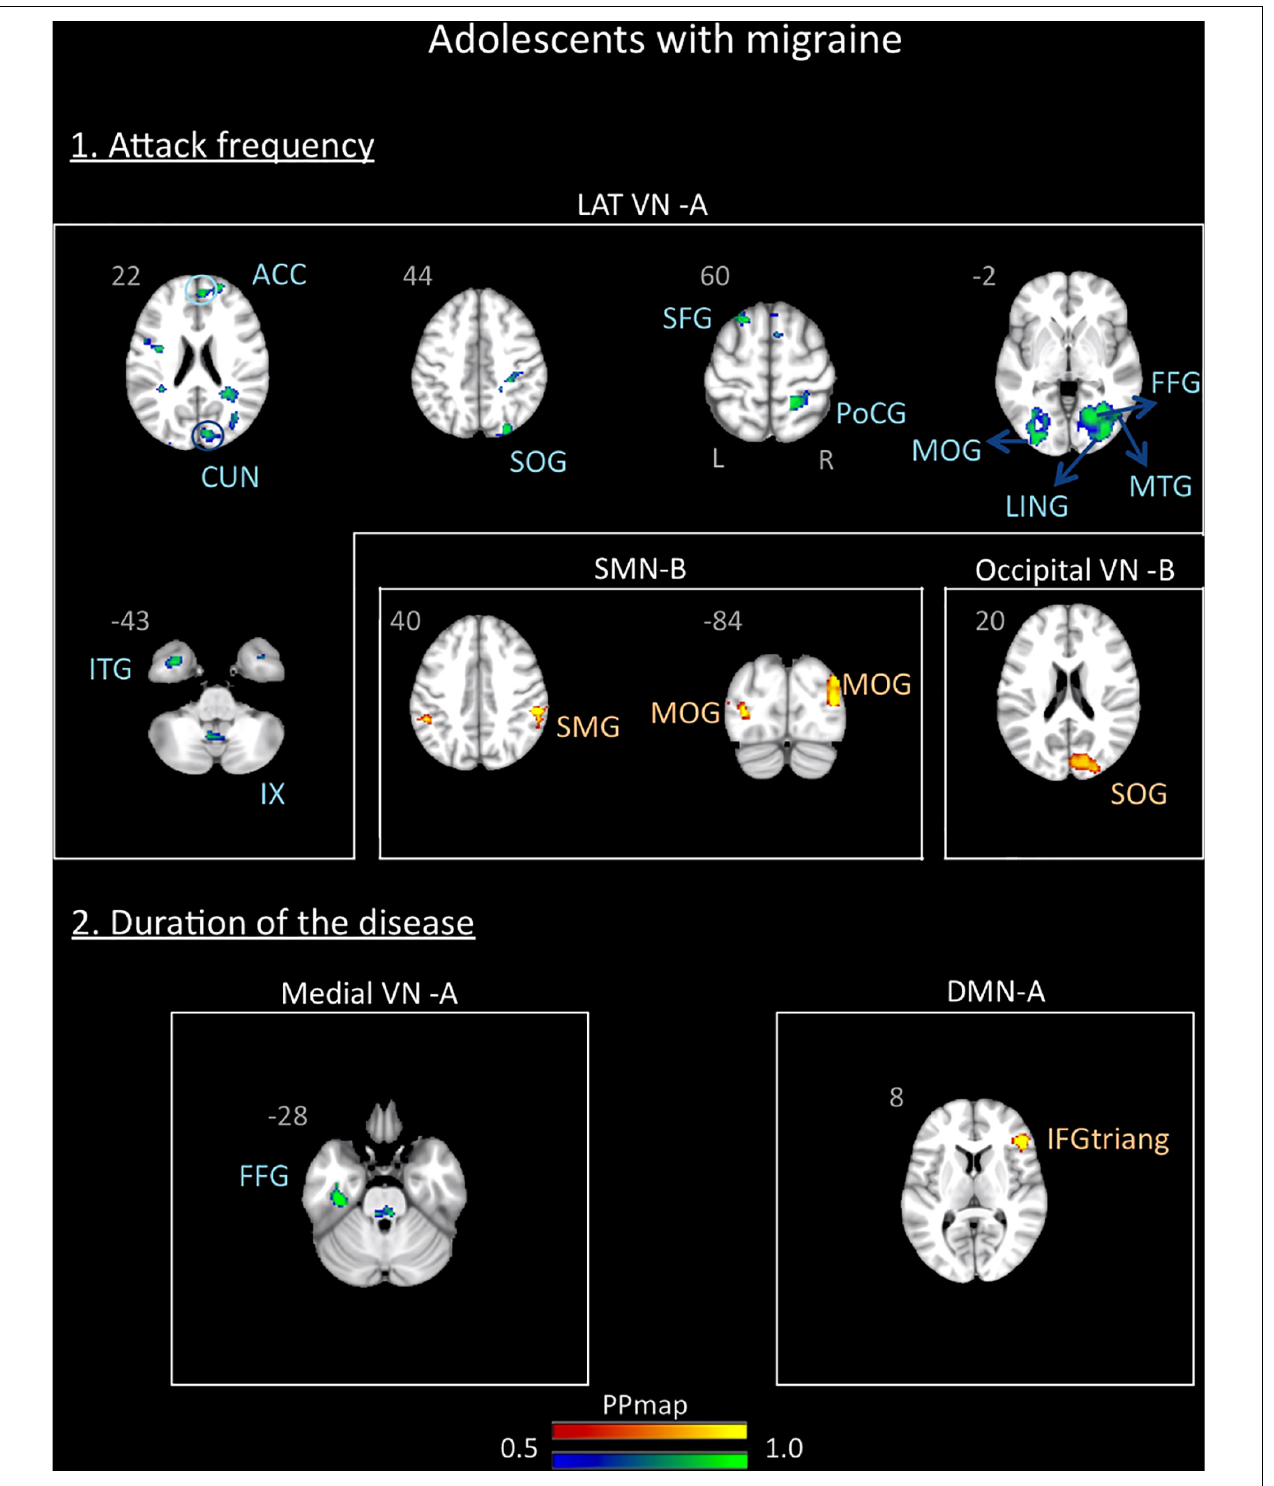
FIGURE 6 | Association between the rs-FC of the adolescents with migraine and two clinical indicators of the disease: attack frequency (per month) and duration of the disease (in years). The figure shows significant positive association between attack frequency and the sensorimotor B and occipital visual B networks and negative association with the lateral visual A network. The duration of the disease was positively associated with the default mode network A and negatively associated with the medial visual A network. See text for further details and Supplementary Table 1 . Numbers refer to the standard MNI Atlas coordinates. Abbreviations of brain regions are described in Table 8